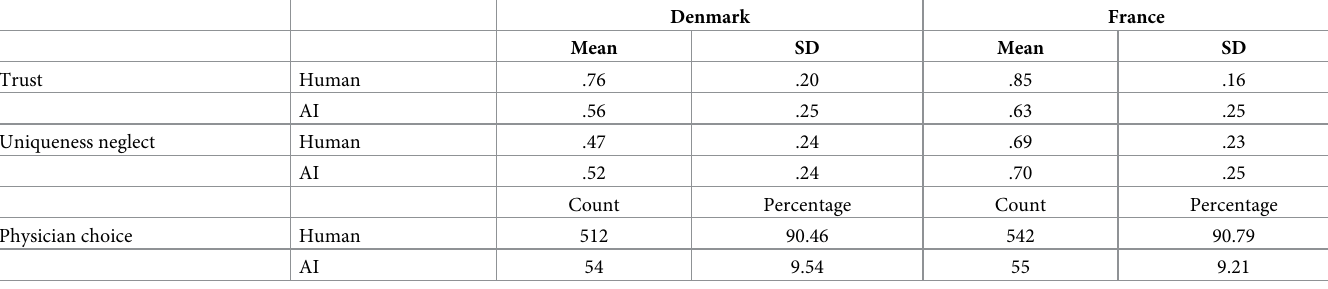
Table 1. Summary statistics of main predictors and choice for Denmark and